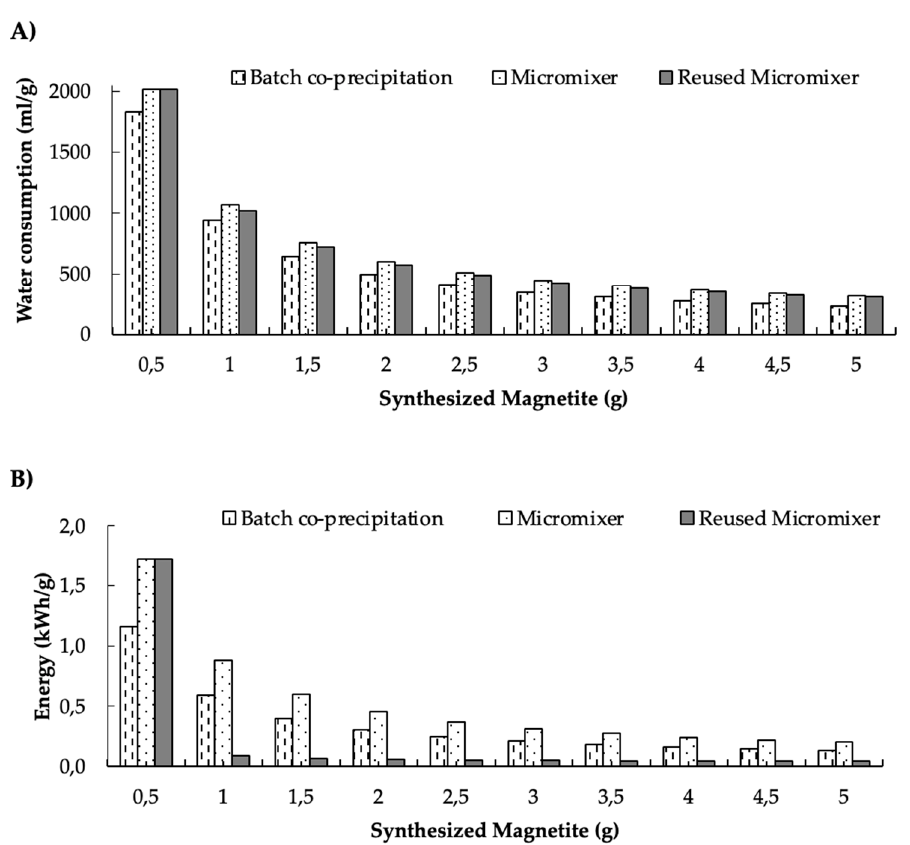
Figure 12. Comparison of consumption between co − precipitation, micromixer − based method, and micromixer reuse methods for the synthesis of magnetite nanoparticles (NPs): ( A ) water consumption per NPs’ gram (mL/g), ( B ) energy consumption per NPs’ gram